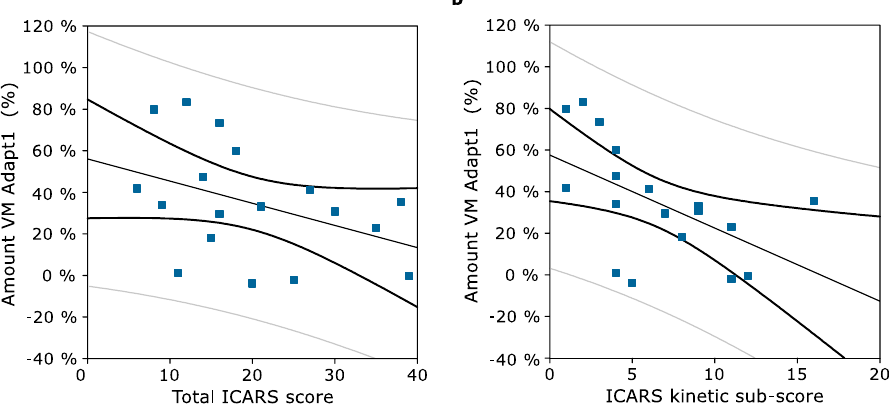
Figure 4. Correlations between the amount of adaptation in VM Adapt1 and patient symptoms. The amount of adaptation reached at the end of the first adaptation phase (VM Adapt1), calculated in percent, was correlated with the CLIN patients’ total ICARS scores ( a ) and with the CLIN patients’ ICARS kinetic sub-scores ( b ). Correlations are represented with the confidence (black thick lines) and prediction (grey thin lines)